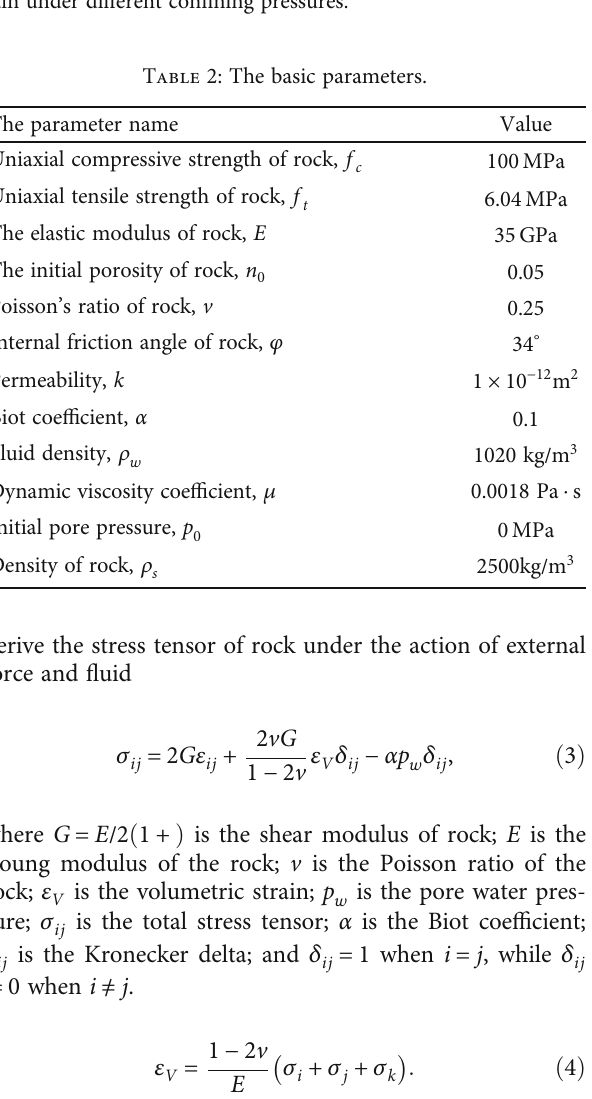
Figure 3: Theoretical curves of rock stress-strain under di ff erent con fi ning pressures.